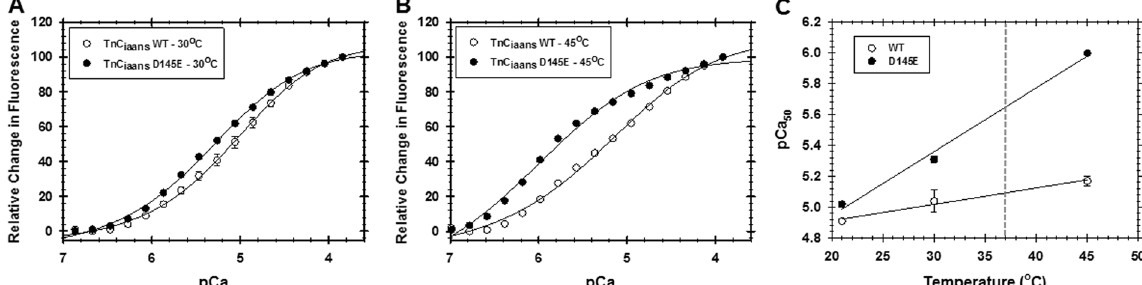
Figure 6. The increase in site II Ca 2 + binding affinity with temperature is greater for D145E than WT. Proteins double-labeled at their native cysteines with the fluorescent probe IAANS were titrated with Ca 2 + in the presence of Mg 2 + at 30 °C ( a ) or 45 °C ( b ). Panel ( c ) summarises the changes in Ca 2 + affinity (pCa 50 ) from 21° to 45 °C, with a vertical dashed line to indicate pCa 50 values extrapolated to 37 °C. Protein concentration was 1 µ M. Excitation was at 330 nm and emission was monitored at 450 nm. Symbols show mean ± s.e.m. (n = 4).